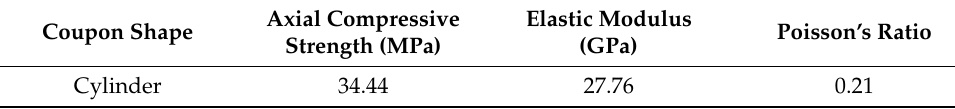
Table 2. Material property indexes of mortar.